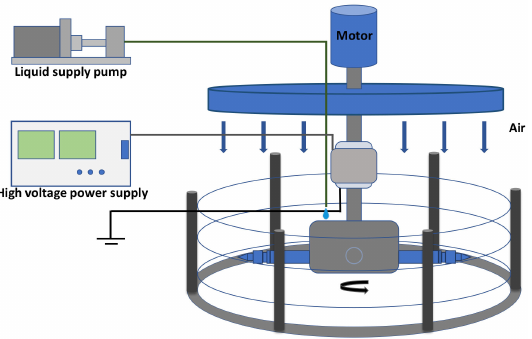
Figure 1. Schematic diagram of the centrifugal electrostatic jet spinning scheme.